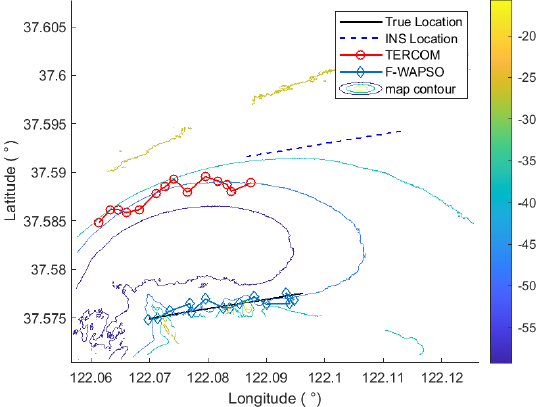
Figure 6. Matching results of the two algorithms.